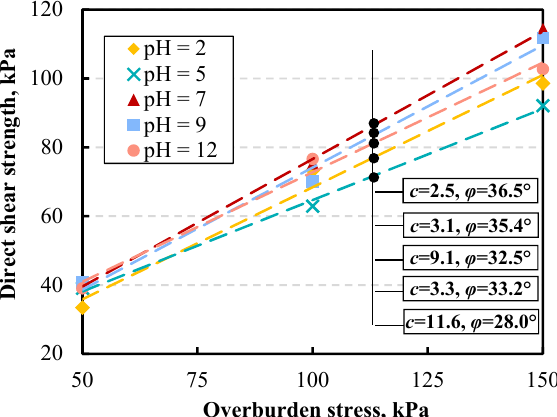
Figure 8. Shear strength, cohesion c , and internal friction angle ϕ of the acid- and alkali-contaminated soils.